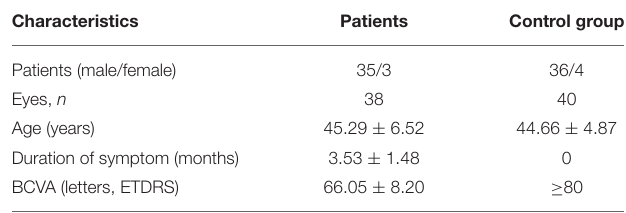
TABLE 1 | Baseline demographic data of the